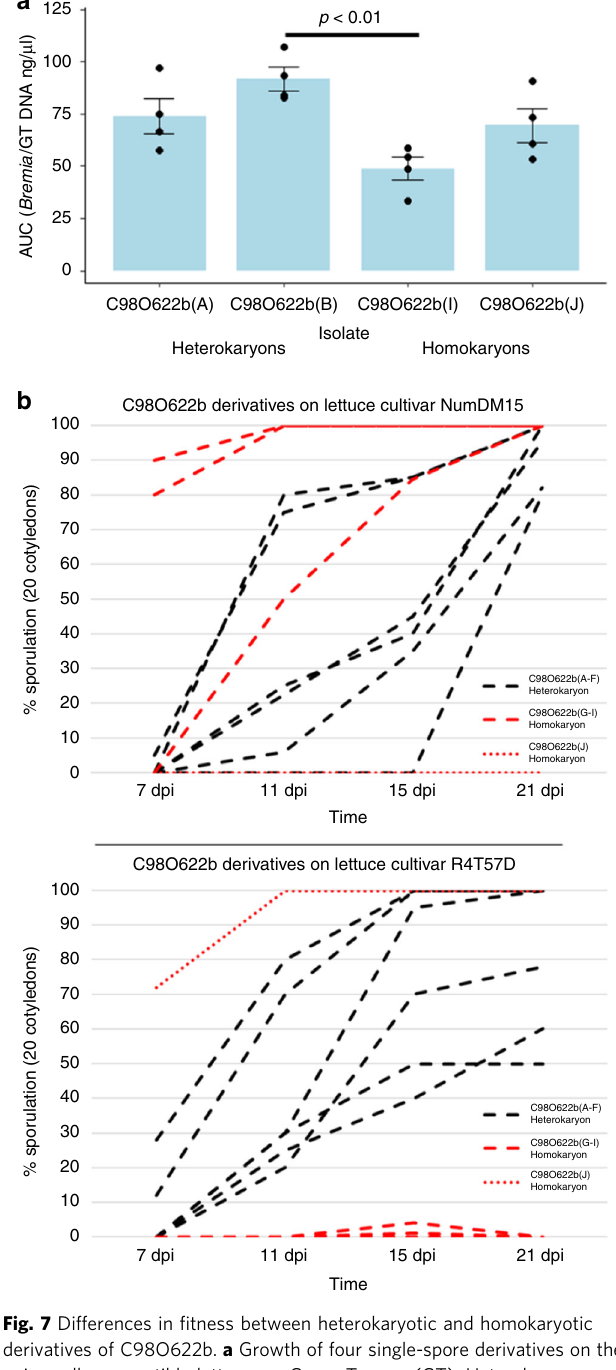
Fig. 7 Differences in fi tness between heterokaryotic and homokaryotic derivatives of C98O622b. a Growth of four single-spore derivatives on the universally susceptible lettuce cv. Green Towers (GT). Heterokaryons exhibit higher growth mass per lettuce seedling and DNA quantity collected per ml of sporangia suspension. Area under the curve (AUC) measurements demonstrate signi fi cantly faster sporulation of heterokaryon derivative B compared with homokaryon derivative I ( p < 0.01, n = 4). Error bars depict standard error over four replicates. b Growth curves of six heterokaryotic isolates (black lines) versus four homokaryotic isolates (red lines) on differential lettuce lines NunDM15 ( Dm15 ) and R4T57D ( Dm4 ) demonstrating that viable homokaryons sporulate faster on selective hosts than heterokaryons. Measurements were taken 7, 11, 15, and 21 days post inoculation (dpi) and sporulation was measure on 20 cotyledons per observation. Source data for all panels are provided in the Source Data fi le